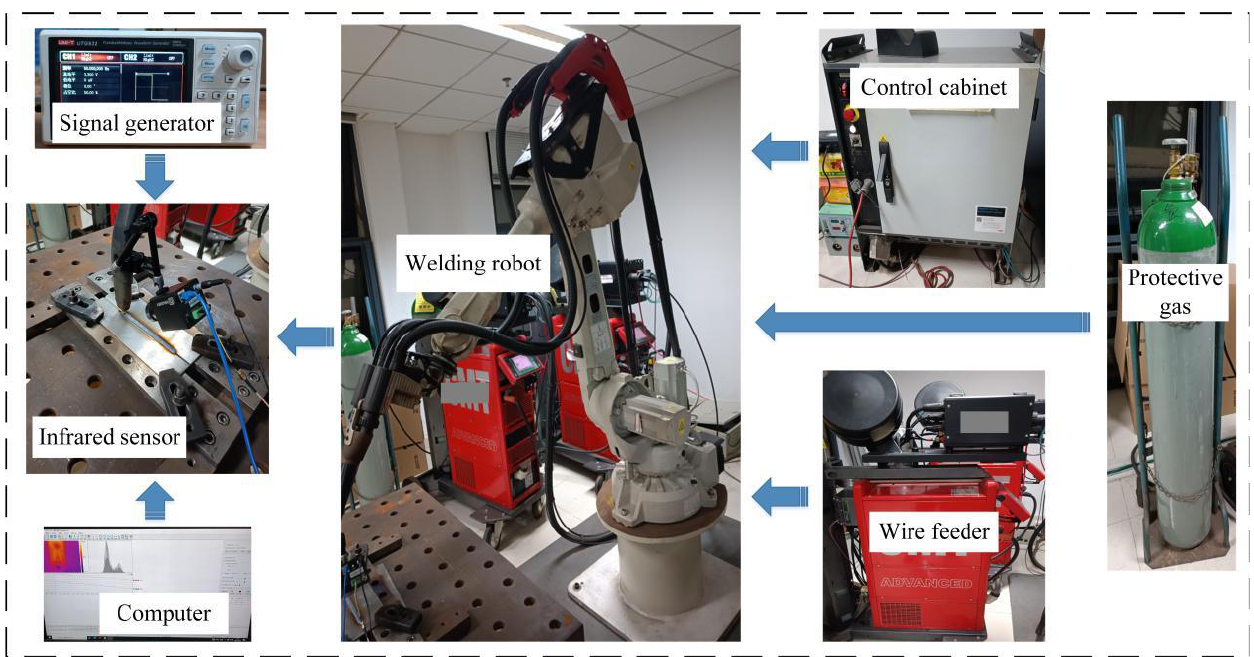
Figure 1. Welding penetration sensing system for variable groove weldments. Table 1. Welding process